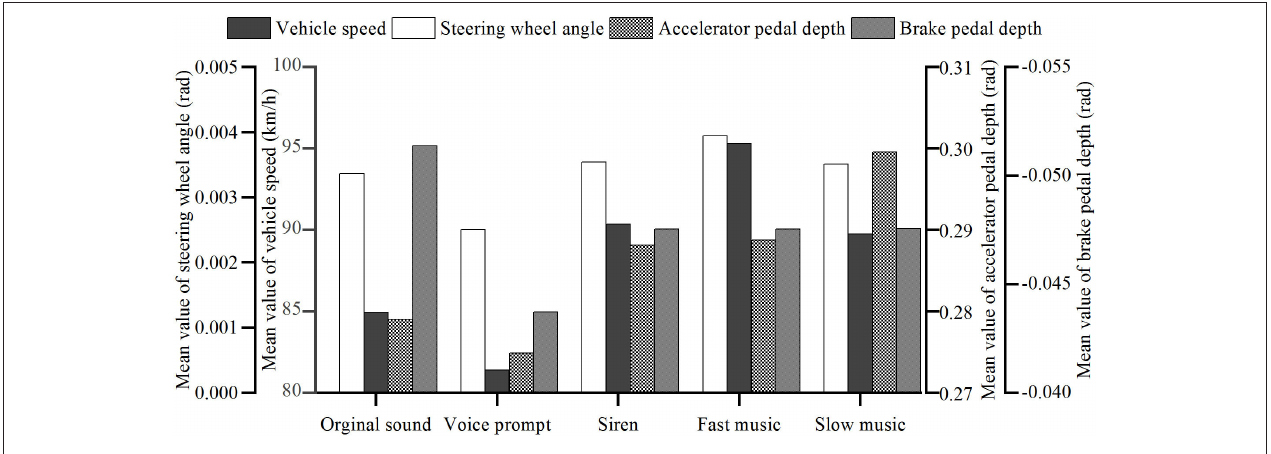
FIGURE 6 | Mean values of vehicle indicators under different sound